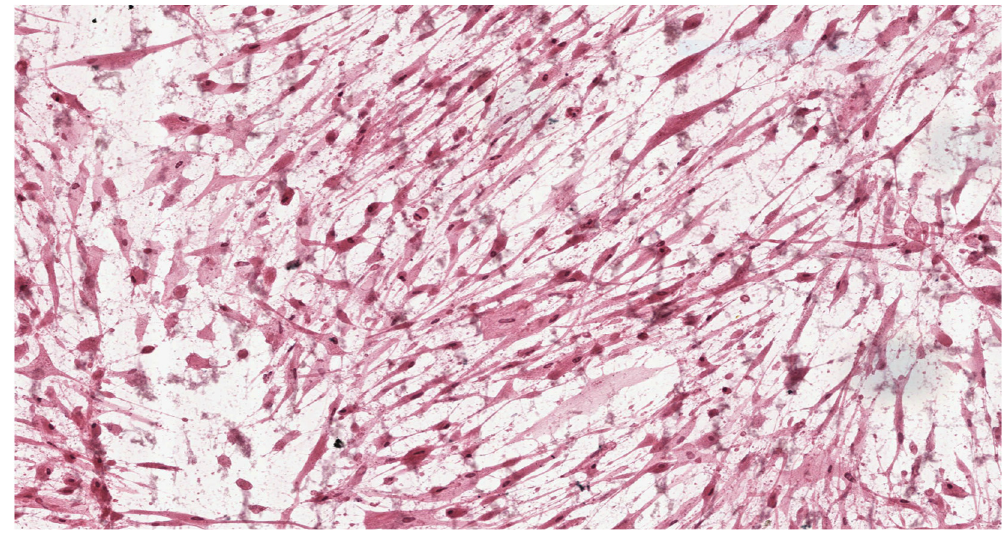
Figure 7. Image of cells cultured on medium with COREGA Extra Strong; 100× magnification.